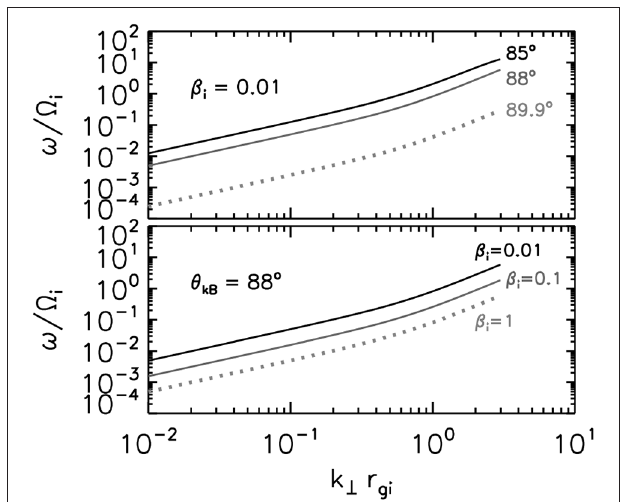
FIGURE 1 | Dispersion relation of kinetic Alfvén mode for different values of ion beta (top) and propagation angles to the mean magnetic field (bottom). Electron-to-ion temperature ratio is set to